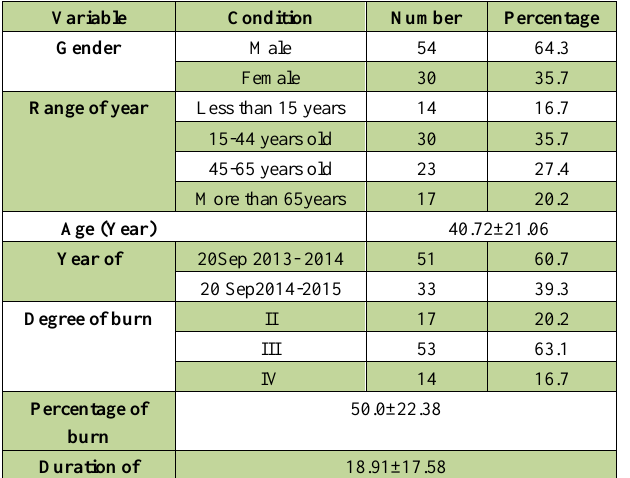
Table 1. Frequency Distribution of Some Demographic Characteristics of Patients Admitted to ICU Burn Center of Rasht City.